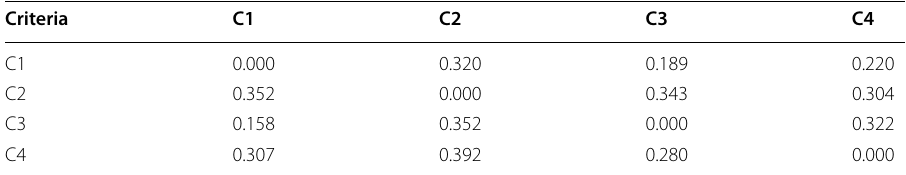
Table 20 Normalized relation matrix for revenue sharing model Criteria